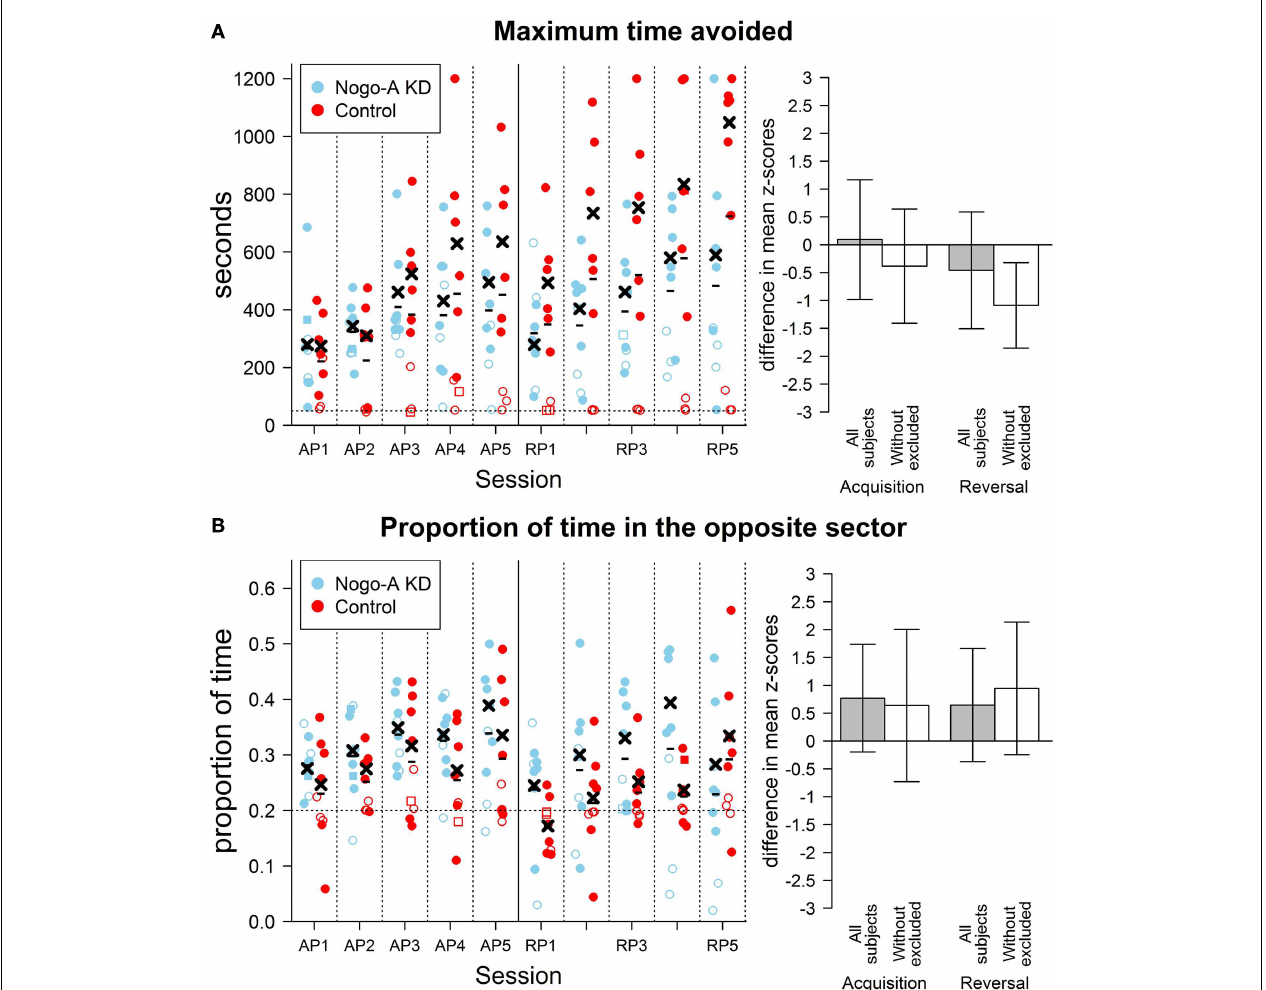
without the excluded rats. Note, especially, the large difference in means for the last few session of the reversal phase.The horizontal dotted line in the left plot represents 50s, which corresponds to a time of maximum time avoided for a subject that is fully immobile.The excluded rats from control group do not usually show better avoidance ability than they would have if they did not move at all. Maximum possible value for maximum time avoided is 1200s, which corresponds to no entrance to the to-be-avoided sector. (B) Results for proportion of time in the opposite sector. A slight, but not significant, increase in the proportion of time in the opposite sector can be seen in Nogo-A knockdown rats in all sessions with exception of the last one.The result is contrary to that expected based on previous research suggesting perseverance in Nogo-A knockdown animals.The horizontal dotted line in the left plot depicts a proportion that would be measured for totally immobile subjects. It can be seen that the three excluded rats from Nogo-A knockdown group have values close to this line.The acquisition phase was not included in analysis and is shown only for